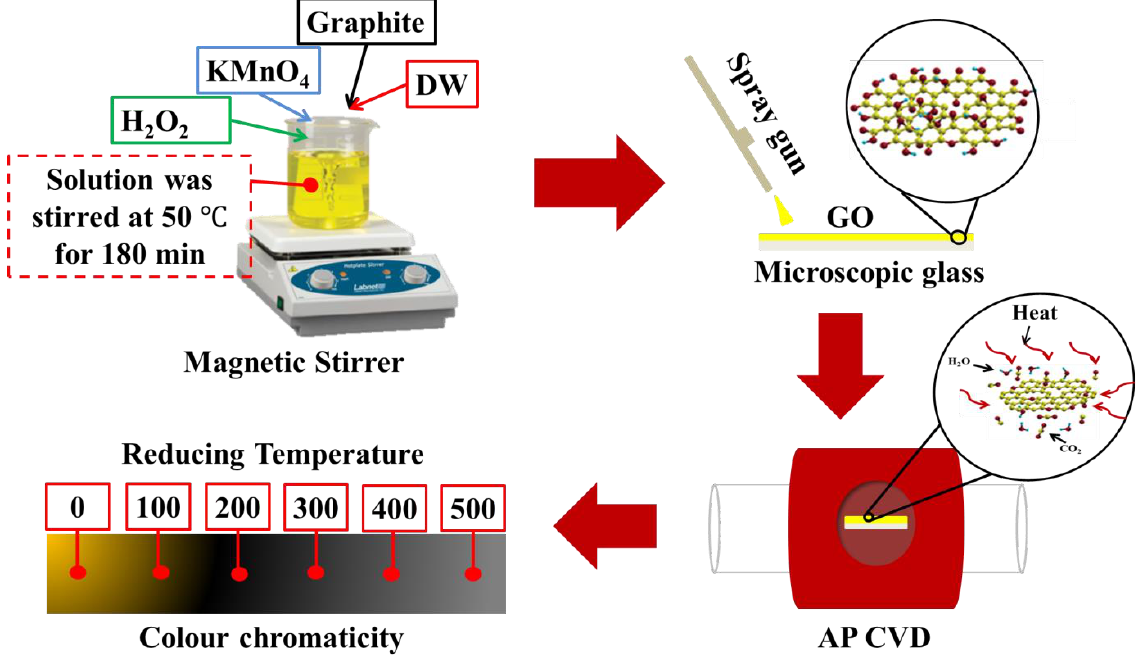
Figure 1. Schematic detailing TRGO thin-film preparation and the colour chromaticity showing the appearance of the prepared thin film.